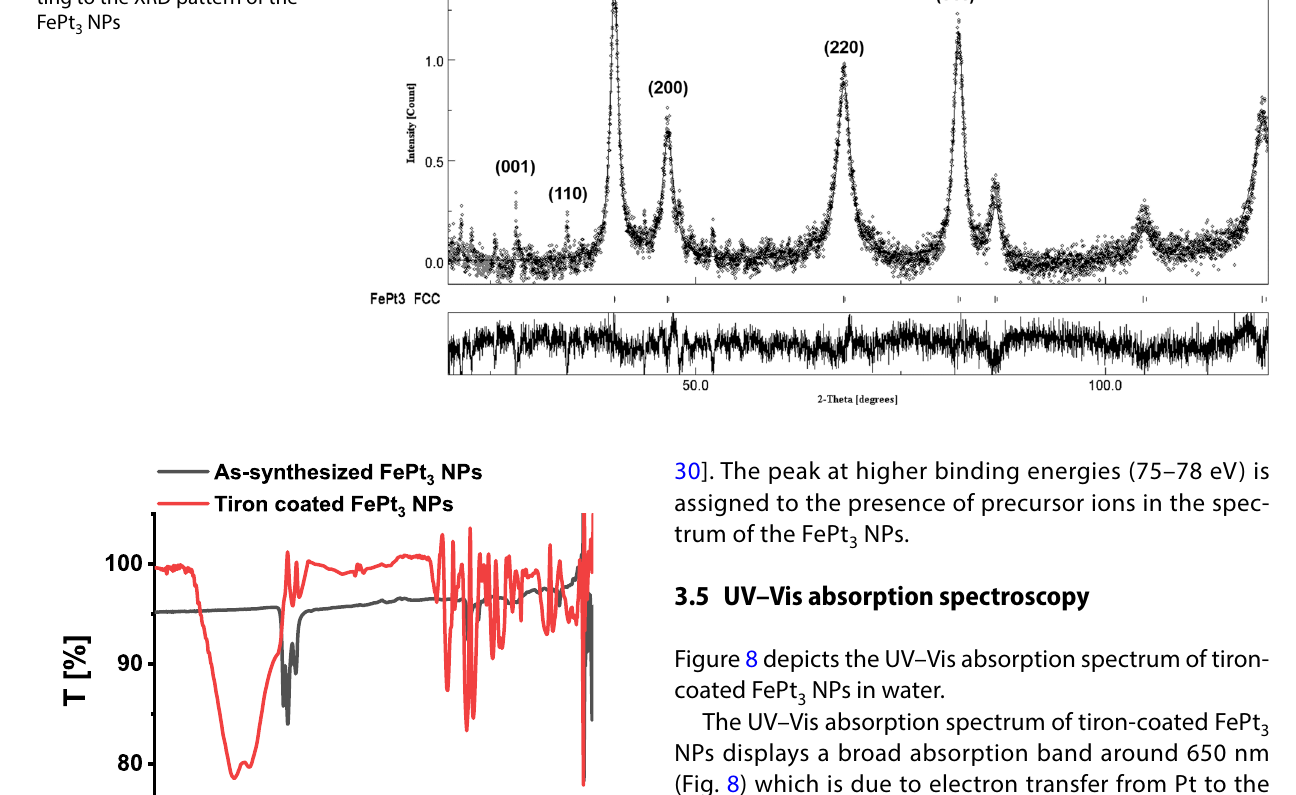
Fig. 3 The Rietveld profile fit- ting to the XRD pattern of the FePt NPs 3